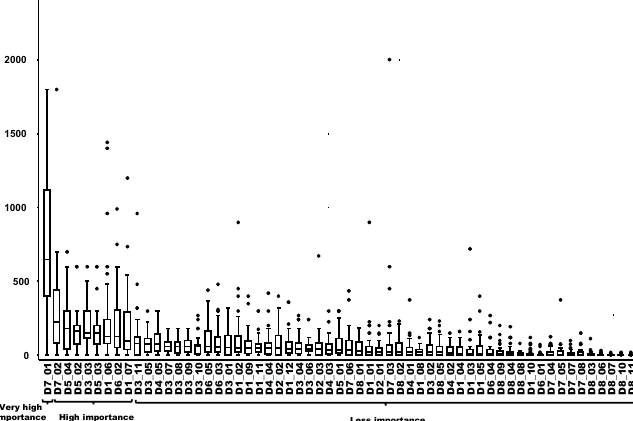
Figure 2. Ranking of the overall weighted score for each potential driver of the observed emergence or increasing incidence of TBE in humans (boxplot based on input from 40 European experts). Legend: The x-axis represents the drivers with the following codification: D1 to D8 refer to the eight domains of drivers, and D1_1 to D8_11 refer to a specific driver (for the codification, see Table A1). A relation to Figure 3 was provided by the group, which named “very high importance”, “high importance” and “less importance”, as possible drivers of the observed emergence or increasing incidence of TBE in humans.